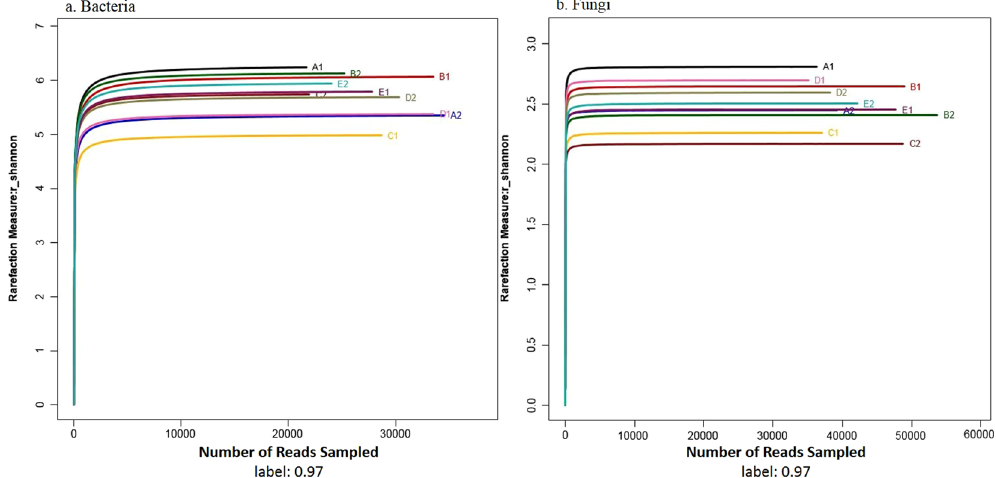
Figure 1. Shannon-Wiener curves of bacterial ( a ) and fungal ( b ) depicting the effect of 3% dissimilarity on the number of OTUs identified in the 10 soil samples. The “A1”, “B1”, “C1”, “D1” and “E1” refers to the five PAT soils in Qixia, Muping, Laizhou, Huludao and Changli. The “A2”, “B2”, “C2”, “D2” and “E2” refers to the five ATS soils in Qixia, Muping, Laizhou, Huludao and Changli,